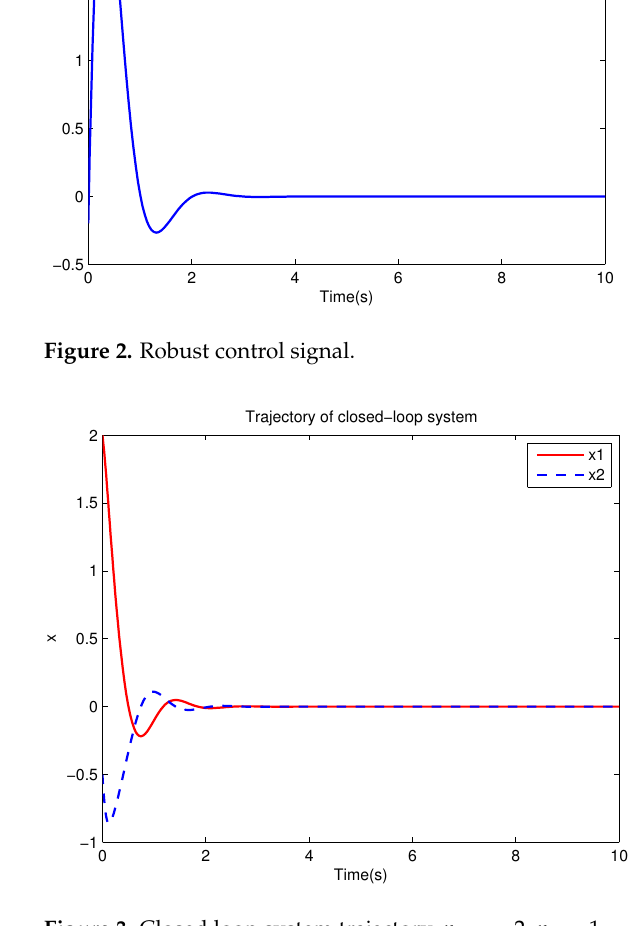
Figure 3. Closed loop system trajectory, p 1 = − 2, p 2 =